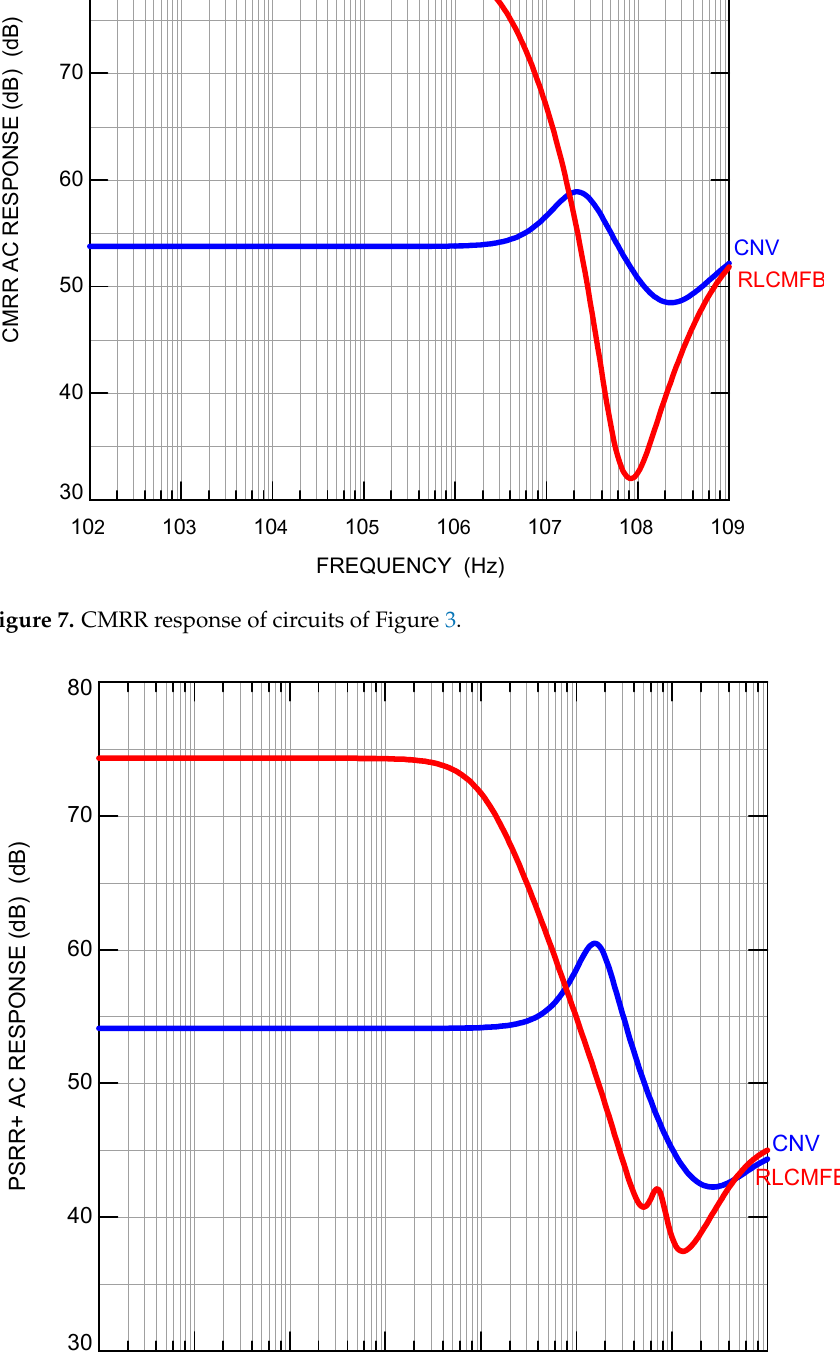
Figure 8. Positive PSRR of circuits of Figure 3.